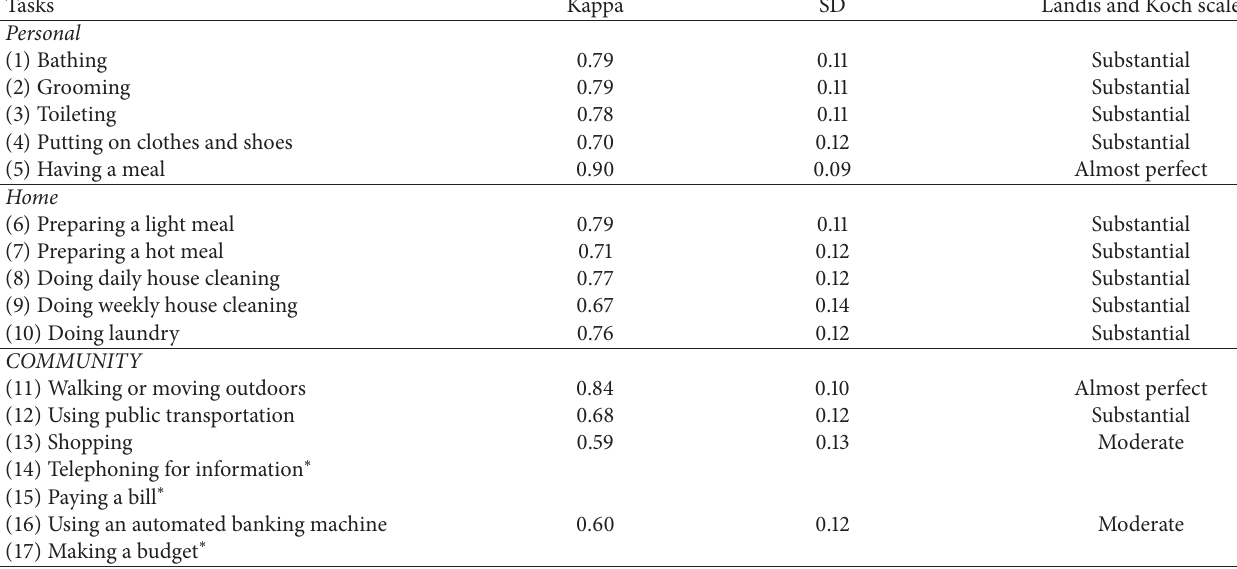
Table 2: Test-retest reliability of the operation of formulating a goal of the ADL Profile.